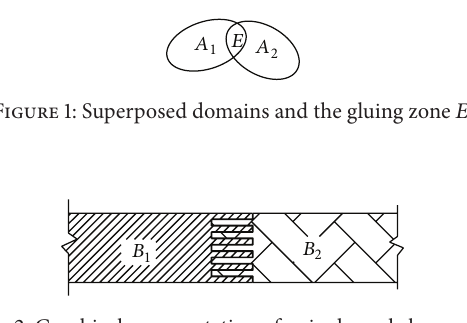
Figure 2: Graphical representation of a single-scale beam